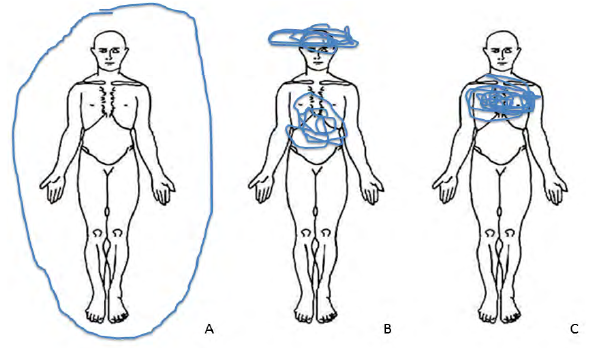
Figure 2. Configurations of somatic self-awareness.